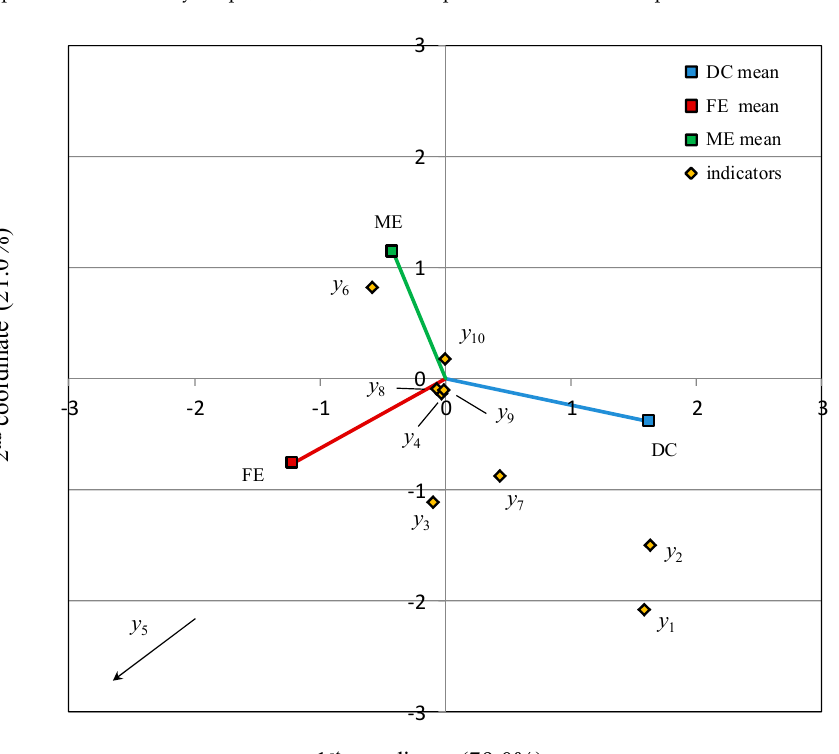
Figure 3. Results of canonical variate analysis showing the relationship between food enterprises and financial ratios (rescaled dual coordinates). Explanation: DC—dairy cooperatives, FE—feed companies, ME—meat enterprises;